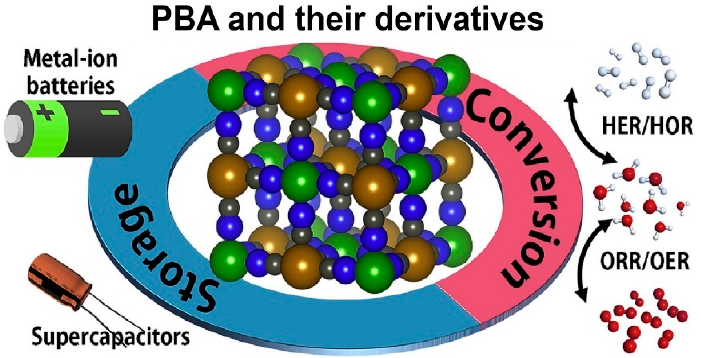
Figure 5. Primary applications of PBA in the field of energy storage and conversion. Adapted with © 2020 the permission from [68]. Copyright © 2020 Elsevier. permission from [68]. Copyright